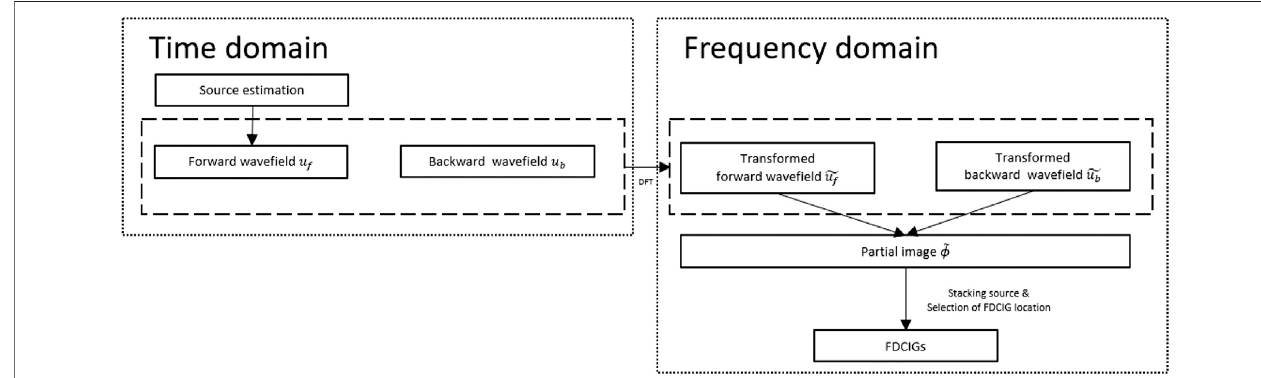
FIGURE 1 | Flowchart of getting FDCIG in hybrid domain. DFT means discrete Fourier transform.